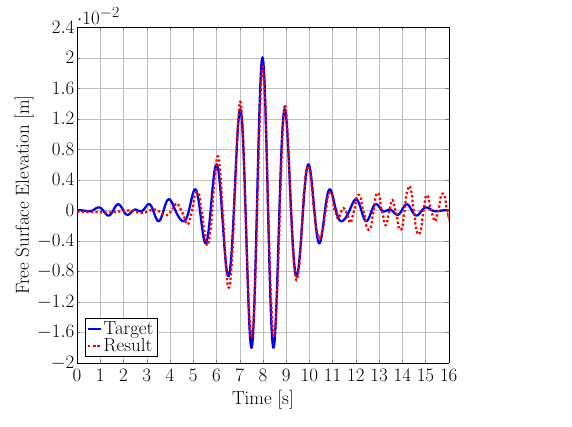
10 − 7 m 2 ) for a source height of d ×